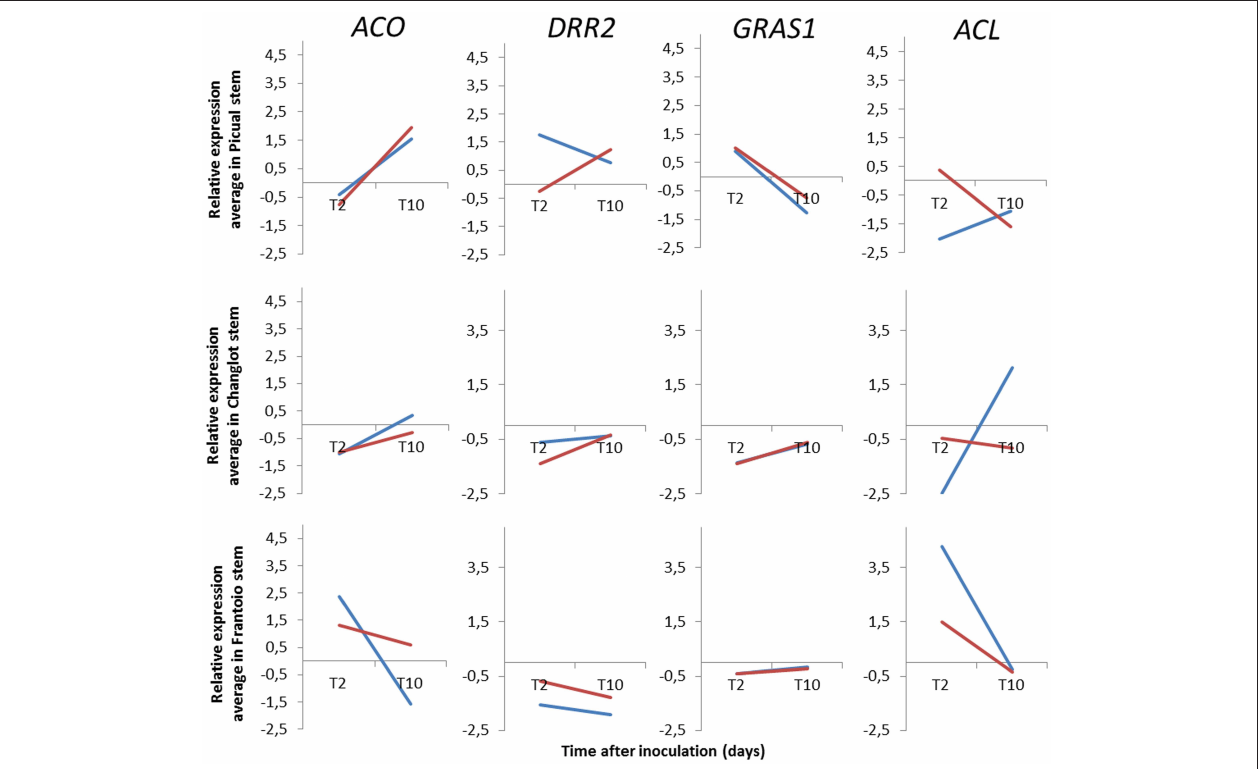
FIGURE 3 | Relative expression (RE) average of four genes from aerial tissues of inoculated tolerant (“Frantoio” and “Changlot Real”) and susceptible (“Picual”) olive cultivars at two different time points after Verticillium dahliae inoculation in roots. ACO , 1-aminocyclopropane-1-carboxylate oxidase; DRR2, disease resistant response protein; ACL , acetone cyanohydrin lyase; GRAS1, transcription factor GRAS1; Relative expression values (log2-fold-change values) were calculated according to the 2 − 11 Ct method (Livak and Schmittgen, 2001). Red and blue lines show RE scored for two different plants sampled at the indicated times after inoculation with the